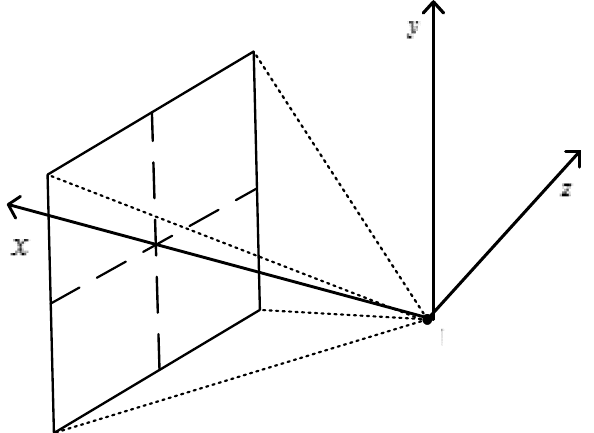
Figure 4. Sensor coordinate system.